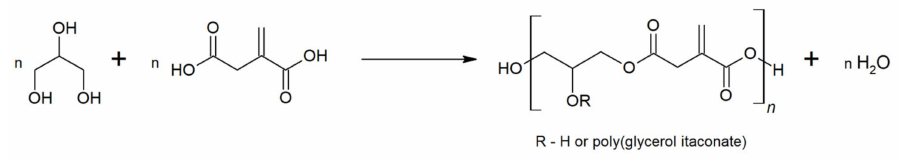
Figure 6. Synthesis of PGItc from glycerol and itaconic